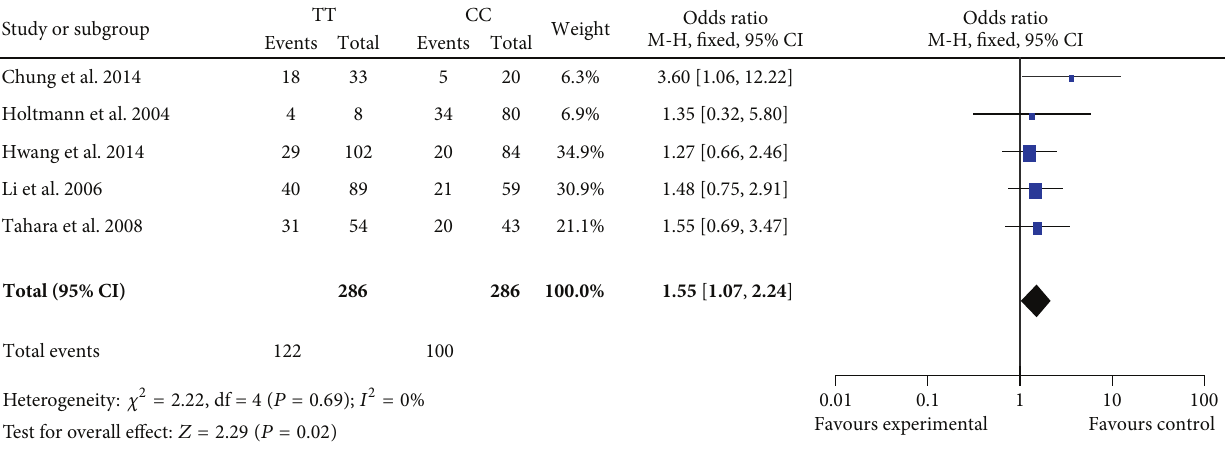
Figure 3: Forest plot of the associations between GNB3 C825T polymorphism and FD risk under additive model based on PCR-RFLP genotyping